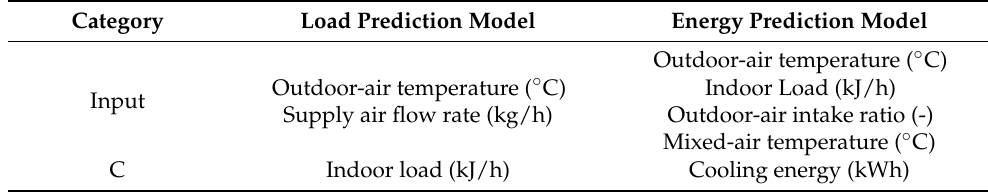
Table 1. Input and output variables of the ANN model.